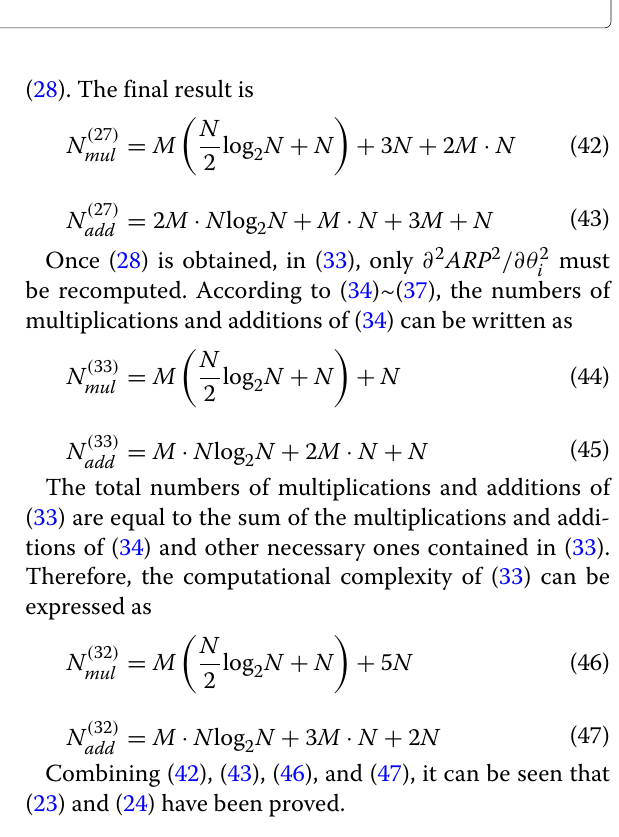
Fig. 16 Estimation results under a − 25 dB SNR. a The estimation result of the proposed algorithm, b the estimation result of the ACM, and c the estimation result of the